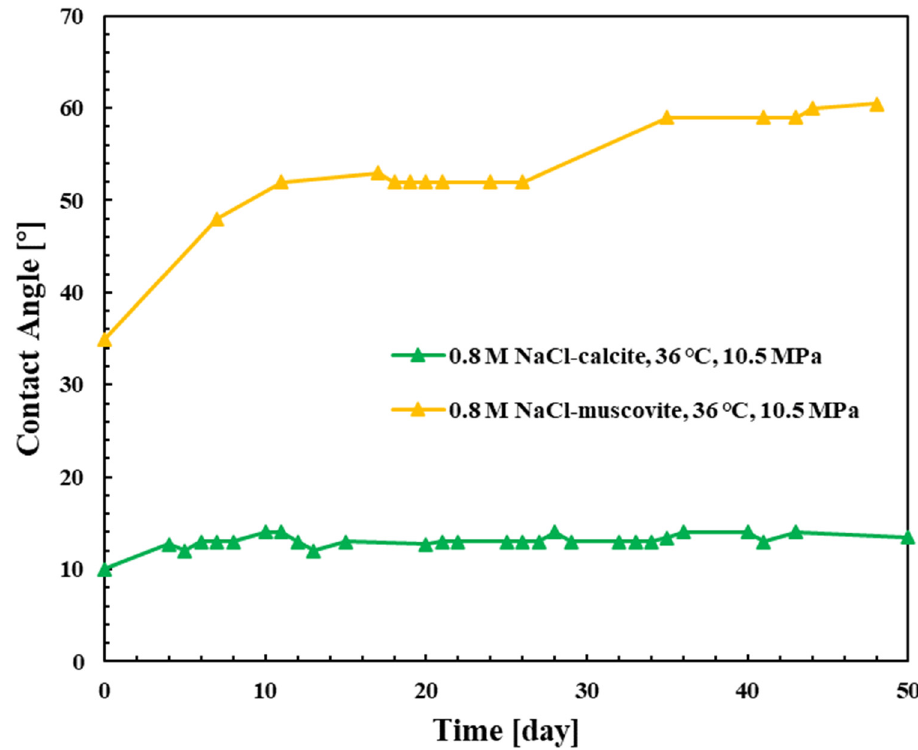
Figure 5. Water contact angle as a function of reaction duration in the CO 2 -NaCl brine-mineral systems after reaction with CO 2 [40].